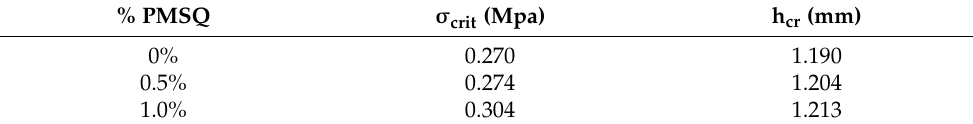
Table 6. Critical values of the von Mises stresses and thickness in the YZ half-plane.